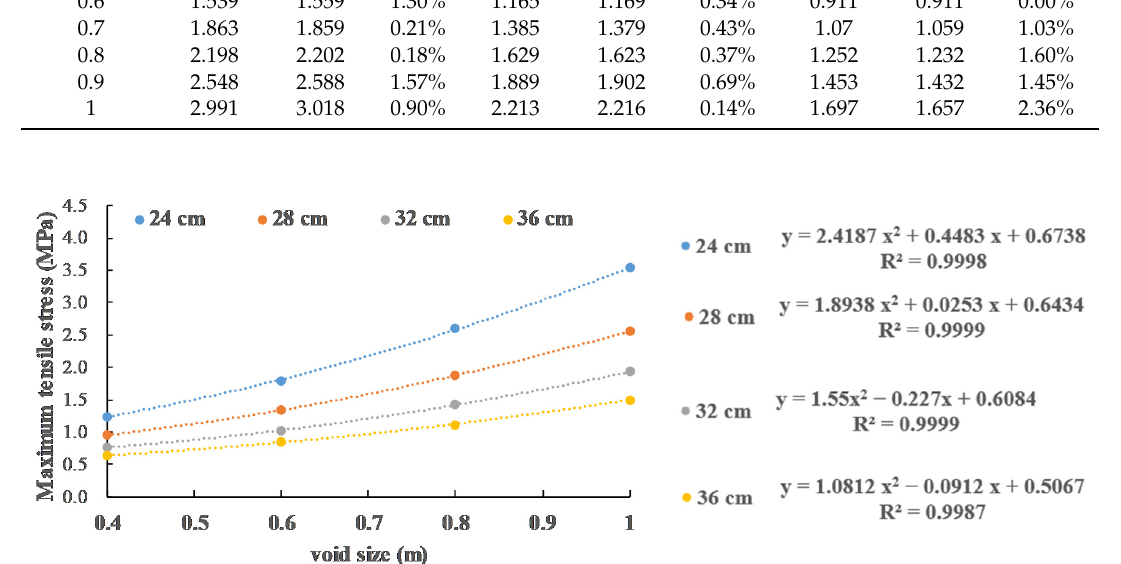
Figure 16. Regression relationship between maximum tensile stress and void size under 0.6 MPa load.